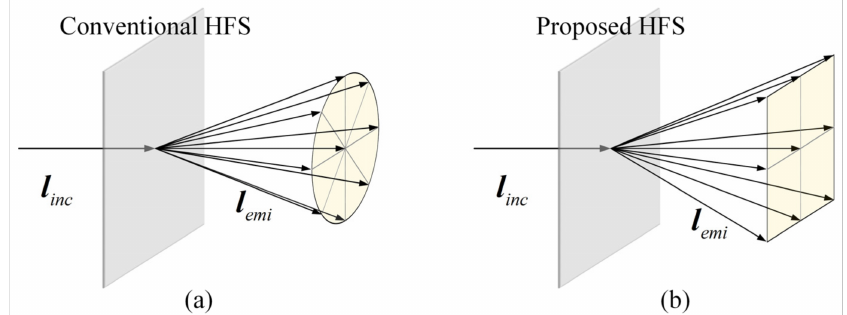
Figure 7. Emitted light distribution with ( a ) conventional HFS, and ( b ) proposed HFS.